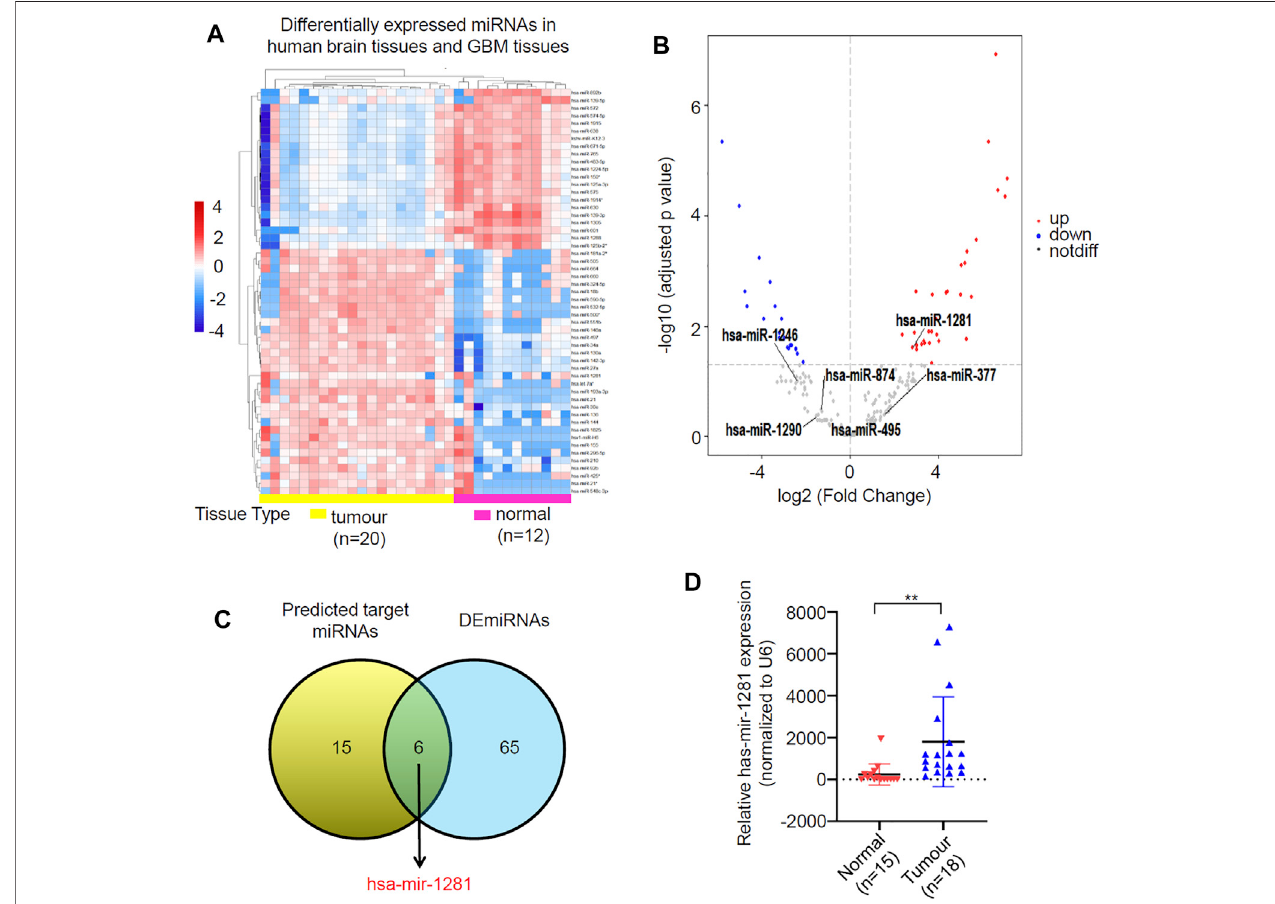
FIGURE 4 | Identi fi cation of circRNAs-miRNAs axis. (A) Clustered heatmap showed pro fi le of the differential expressed miRNAs in human brain tissues and GBM tissues. The color scale indicates the foldchange of the log2 value of the reads for each gene in tumors vs. normal tissues (red represents up-regulation; blue represents down-regulation). (B) VolcanoplotofdeferentiallyexpressedmiRNAsinGBMrelativetonormalbraintissues.ThereddotsrepresentupregulatedmiRNAsandbluedots represent downregulated miRNAs with statistical signi fi cance (|log2FC > 1 and p -value < 0.05). (C) Identi fi cation of miR-1281 as the potential target miRNA of circLRRC7. (D) qPCR analysis of the expression levels of has-miR-1281 in normal and GBM tissue samples collected in our hospital. (** p <